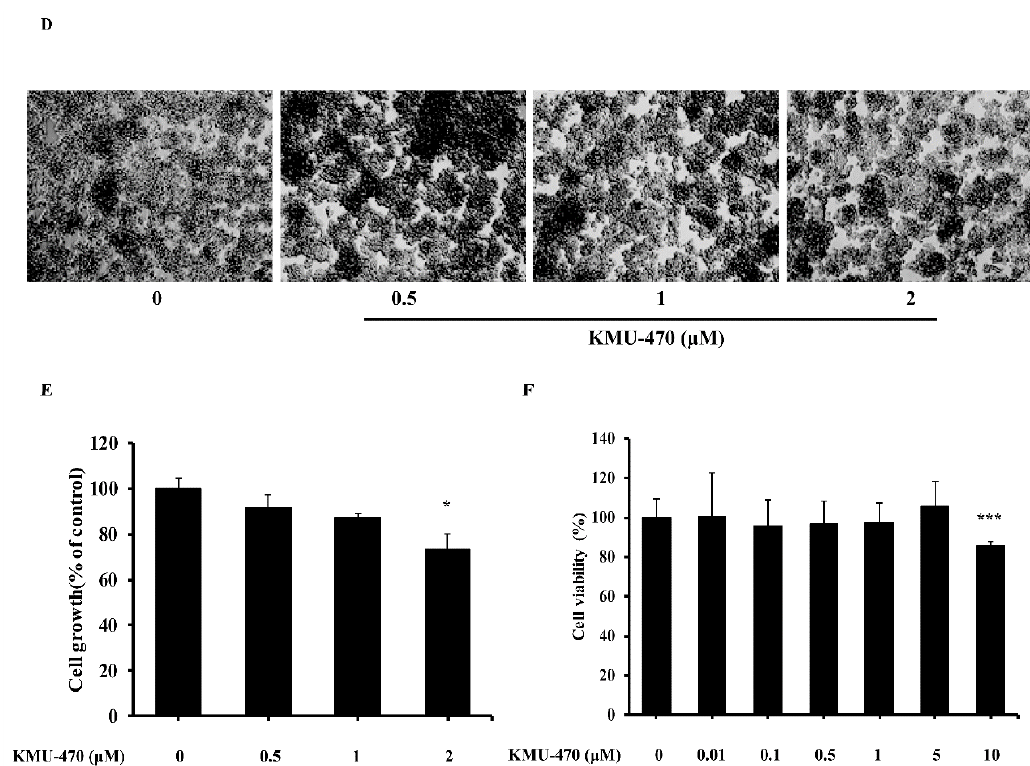
Figure 3. Inhibitory effect of KMU-470 on LPS-induced NO production and iNOS protein expression, and cell viability in RAW 264.7 cells. ( A ) The cells were pre-treated with KMU-470 at a concentration of 1 μM for 30 min and then treated with different concentrations of LPS for 24 h. Nitrite in the culture supernatant was collected and evaluated using Griess reagent. Absorbance was measured at 540 nm. *** p < 0.001, ** p < 0.01, * p < 0.05. ( B ) Cells are pre-treated with two different concentrations of KMU-470 (0.5 μM and 1 μM) for 30 min, followed by treatment with 1 μg/mL LPS for 24 h. β-actin was used as an internal control for Western blot analysis. ( C ) Image-J program was used to analyze the relative optical density of the iNOS band. ( D ) Cells were treated with various concentrations of KMU-470 for 24 h. The effects of KMU-470 on cell proliferation and morphological changes were observed by microscopy (X100). ( E ) The cell proliferation rate was determined by cell count using a trypan blue exclusion assay. * p < 0.05 ( F ) Effect of KMU-470 on cell viability was measured by XTT assay. *** p < 0.001.